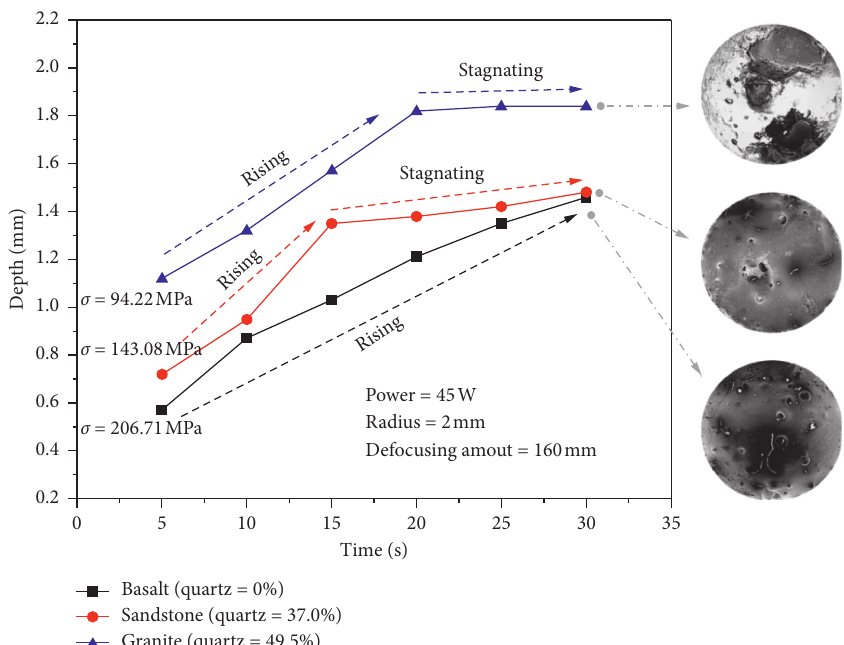
Figure 8: Effect of the laser irradiation time on the rock perforation depth.